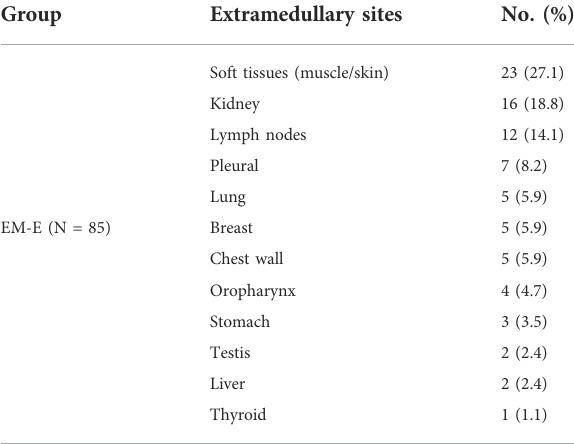
TABLE 2 Distributions of involved sites in patients with